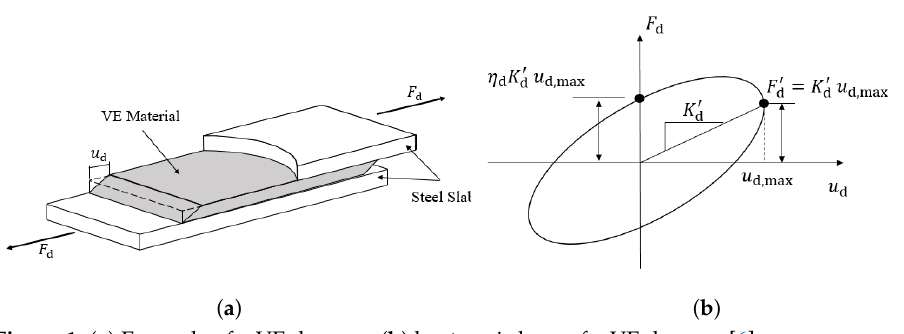
Figure 1. ( a ) Example of a VE damper; ( b ) hysteresis loop of a VE damper